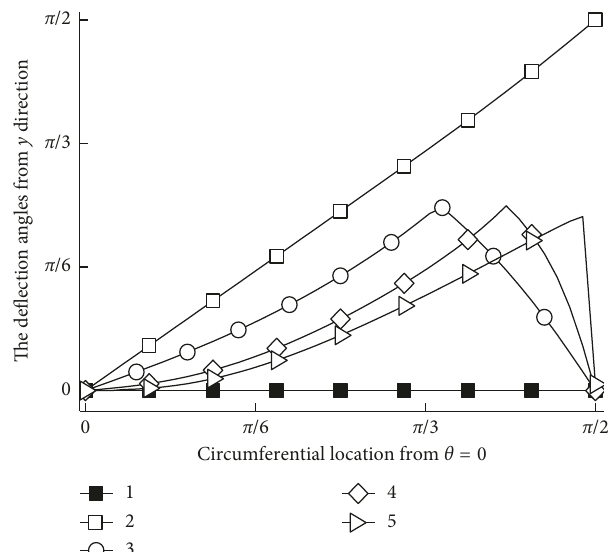
Figure 8: Deflection angles of maximal principal stress at different